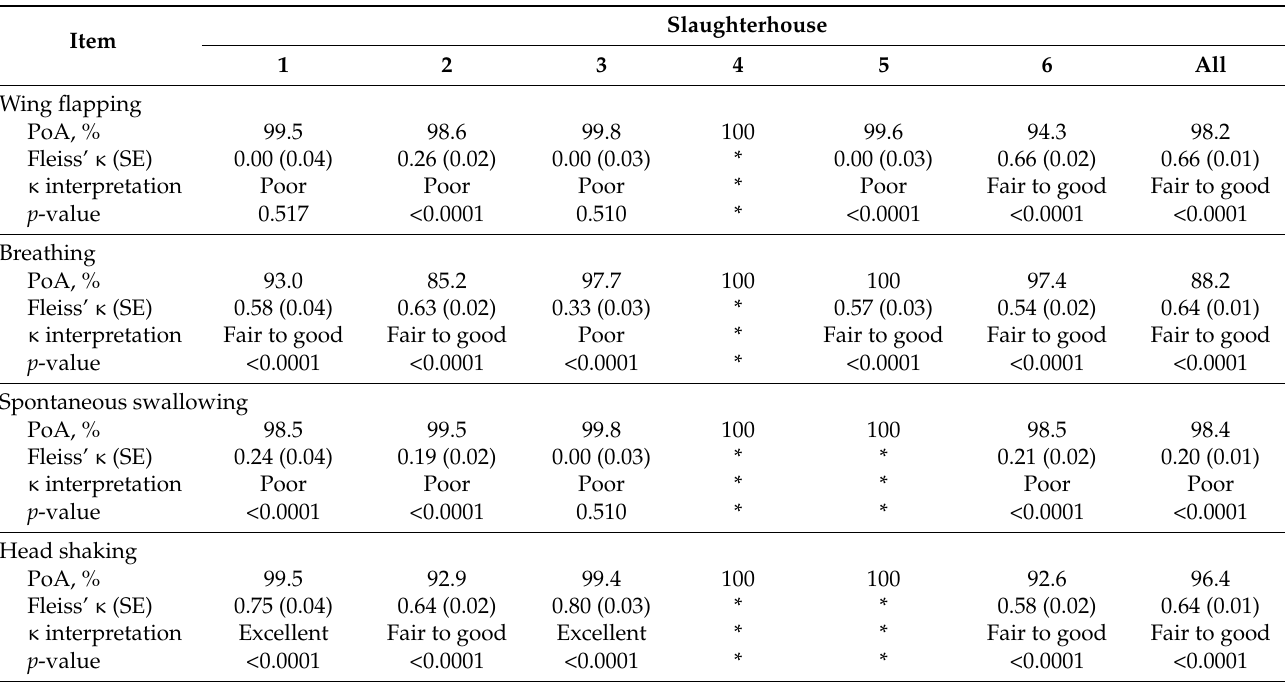
Table 8. Inter-observer proportion of agreement (PoA), Fleiss’ kappa coefficient ( κ ) and its interpre- tation and standard error (SE) of the animal-based indicators for the state of consciousness during bleeding according to the slaughterhouse